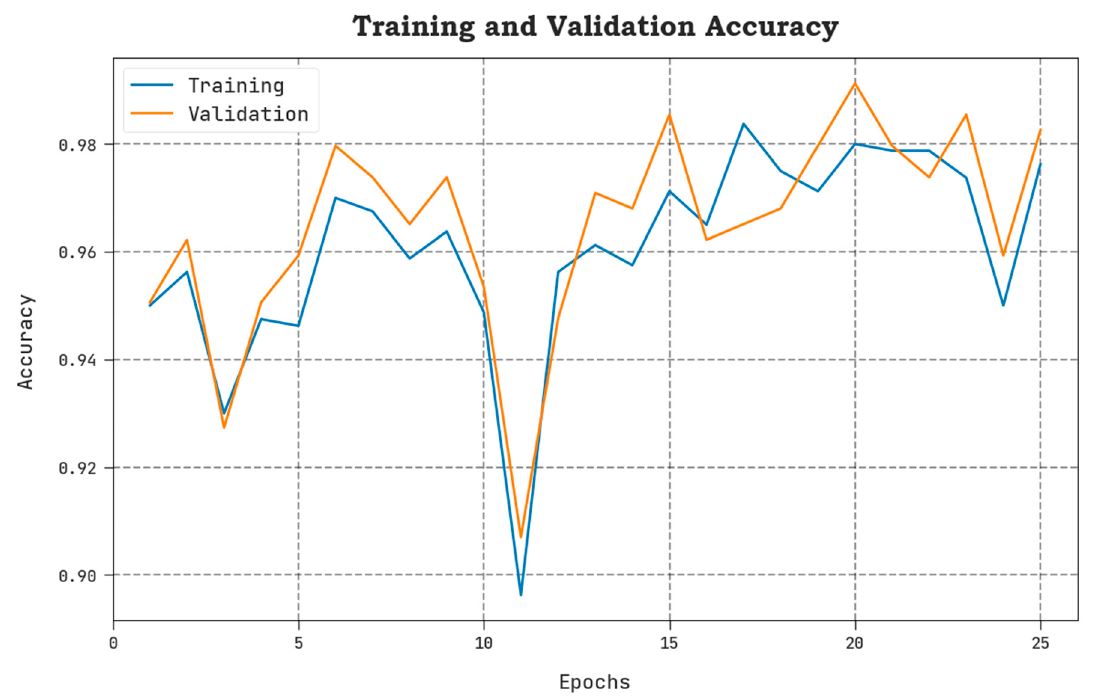
Figure 11. TACY and VACY analysis of AAOXAI-CD approach on dataset-2. The TLOS and VLOS of the AAOXAI-CD model on dataset-2 are defined in Figure 12. The figure inferred the AAOXAI-CD system has better outcomes having minimal values of TLOS and VLOS. Visibly the AAOXAI-CD model has minimal VLOS outcomes.